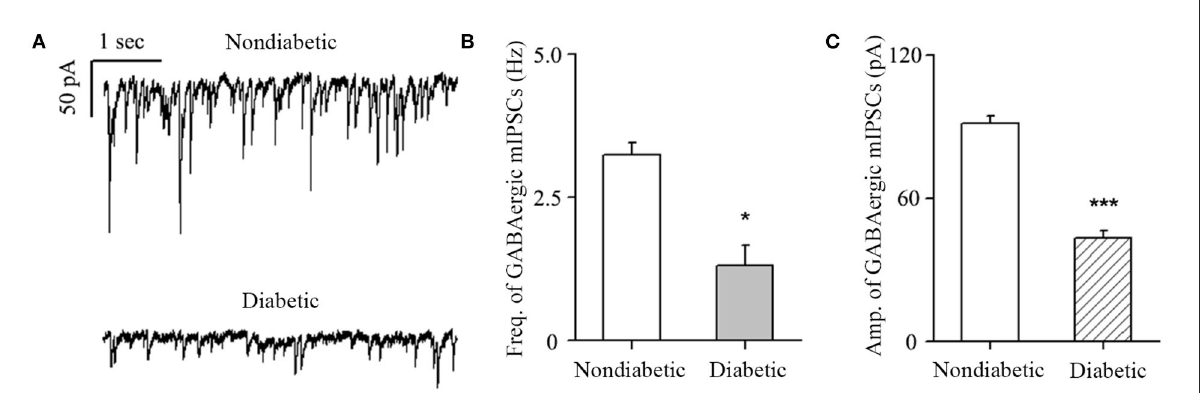
FIGURE1 Changes in GABA current frequency and amplitude. (A) Representative traces of voltage clamp recordings of GABAergic mIPSCs in the presence of TTX (1 µ M) in non-diabetic and diabetic retinas at 4 weeks after diabetic model establishment. The baseline frequency and amplitude of mIPSCs in the retina were markedly reduced in the diabetic group compared with the non-diabetic group. (B,C) Histograms showing the mean frequency and amplitude of the mIPSCs for non-diabetic and diabetic retinas. * p < 0.05, *** p < 0.001 (Student’s paired t -test).